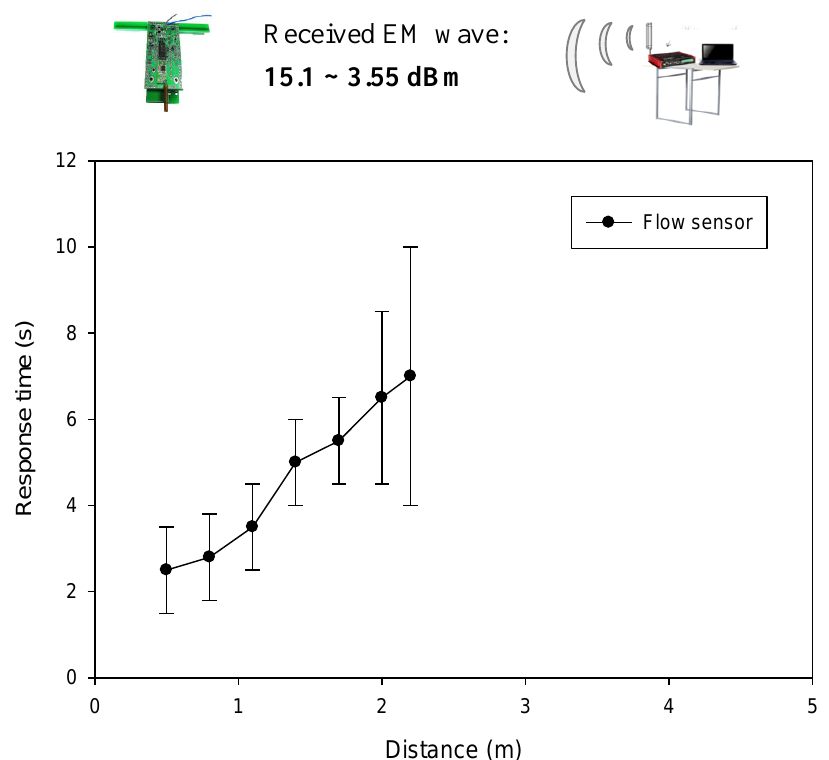
Figure 21. Response time of a WPWS equipped with flow